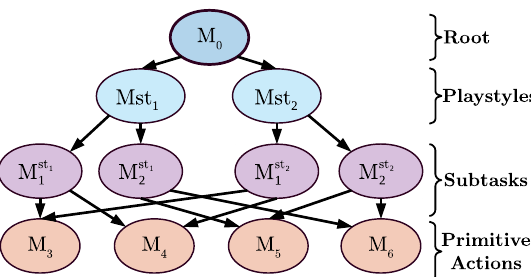
Figure 2. An example of a HRLB^2 task